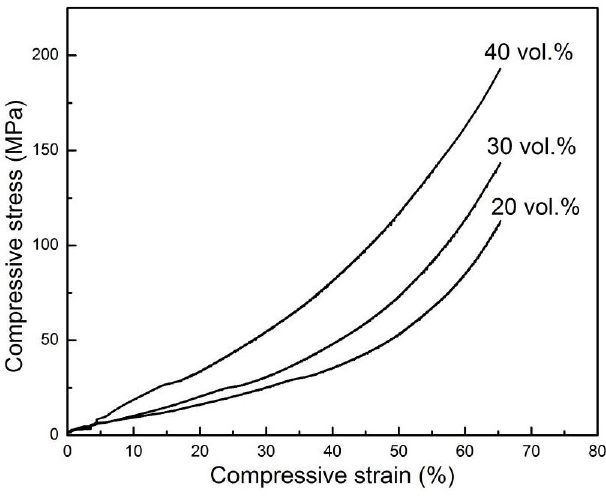
Figure 5. The stress-strain curves of porous Cu bodies with various solid